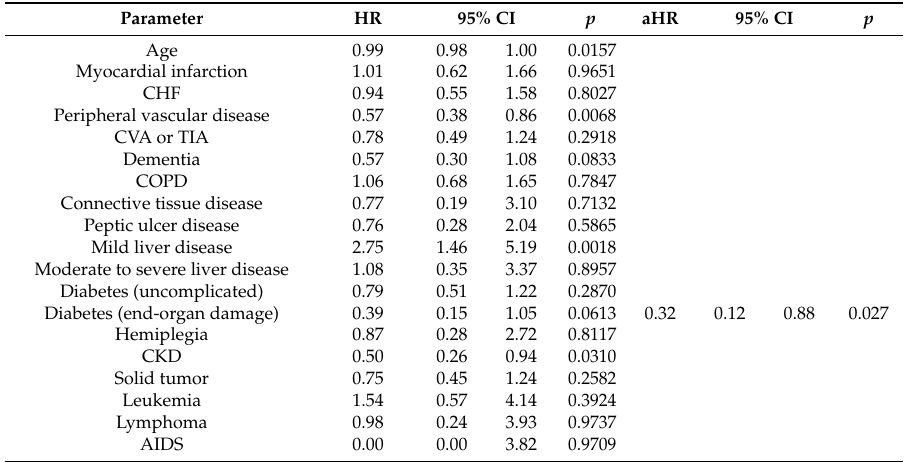
Table 5. Crude (HR) and adjusted hazard ratio (aHR) for LEE grade ≥ 2 according to baseline comorbidities. Parameter HR 95%